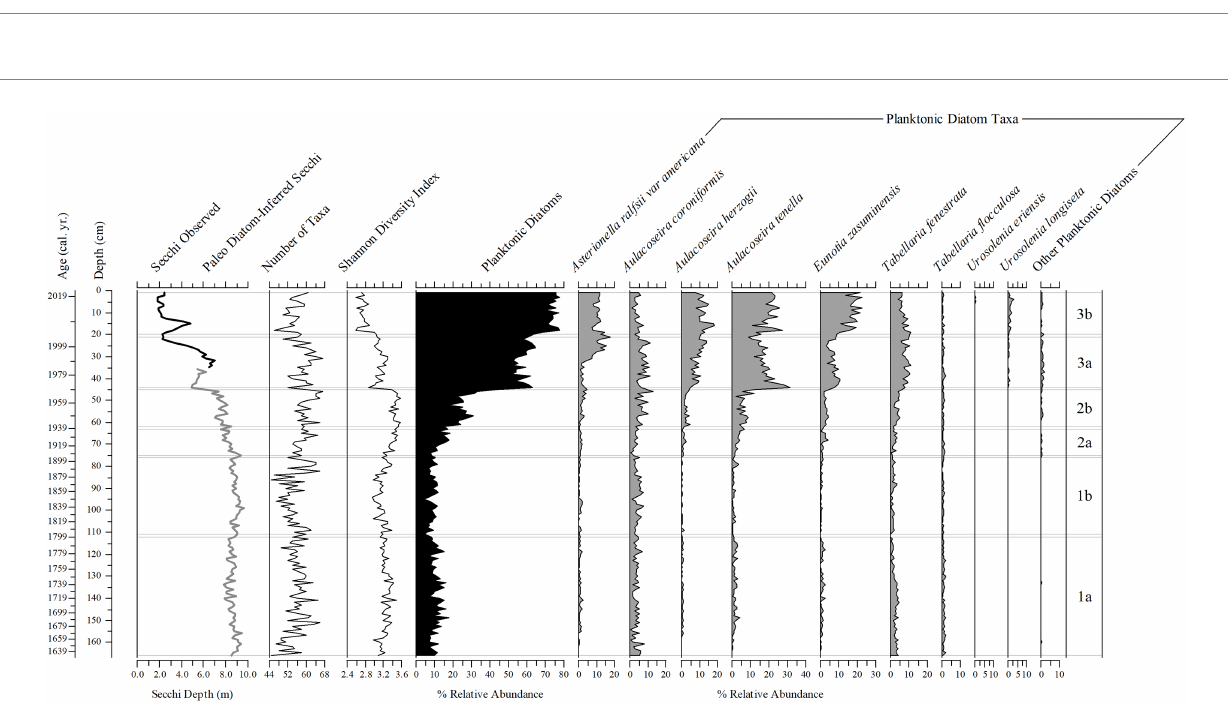
FIGURE 9 Stratigraphic plots of Secchi depth (observed – black line and diatom-inferred – gray line), number of diatom taxa present, Shannon Diversity Index, the percent relative abundance of planktonic diatom taxa, and the percent relative abundance of nine planktonic diatom taxa found throughout the 166 cm (1633–2019) sediment core. Subzones (right 1a–3b) are determined by the change in diatom assemblage from a constrained cluster